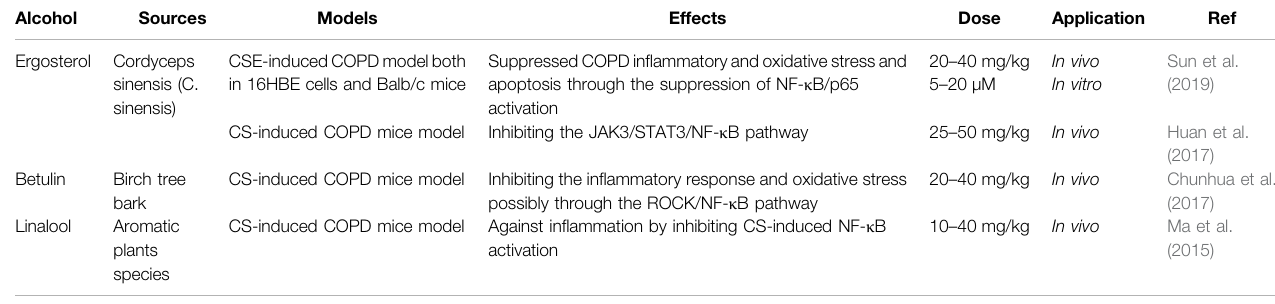
TABLE 8 | The effects of alcohol on COPD.